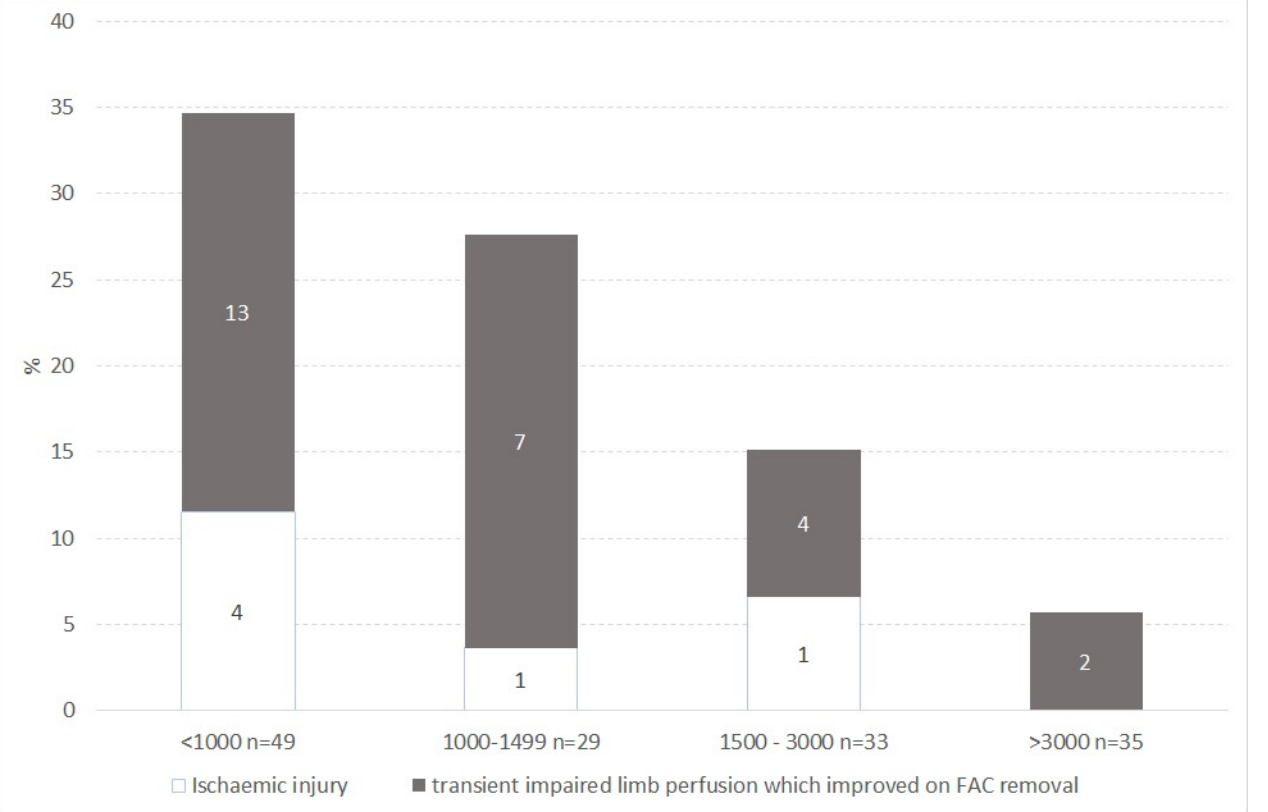
Figure 1. Proportion of FAC causing transient impaired limb perfusion which improved on FAC removal and ischaemic injury by weight category at time of insertion. n = the number of FAC inserted in each weight category.